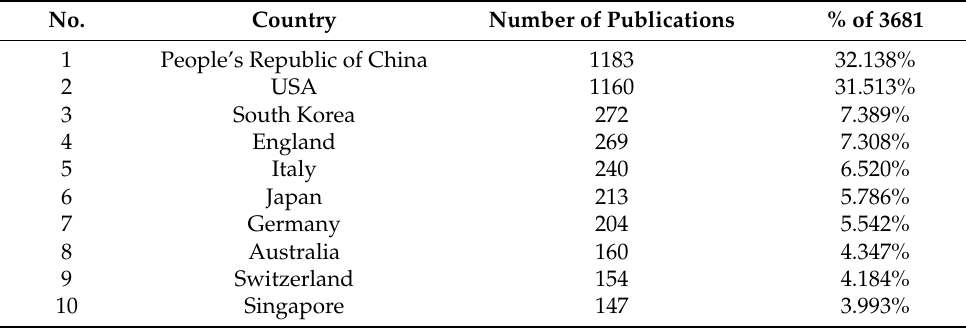
Table 3. Top 10 countries that have published in the field of soft